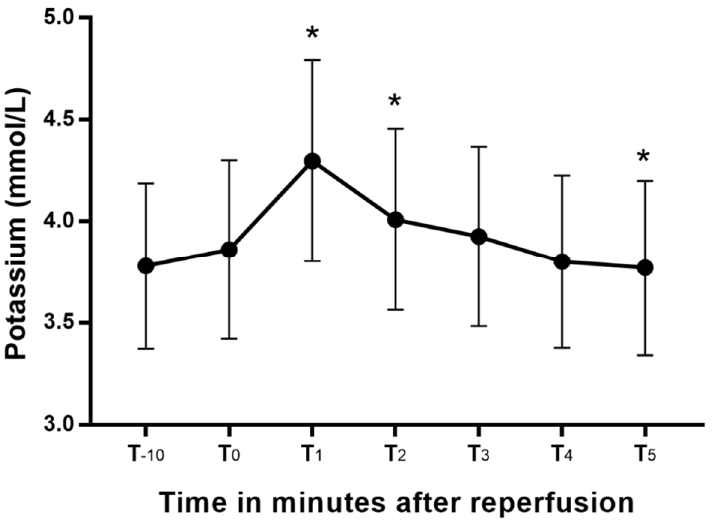
Figure 1. Blood potassium changes after reperfusion presented as a box-whisker plot. *: p < 0.05 versus T 0 .